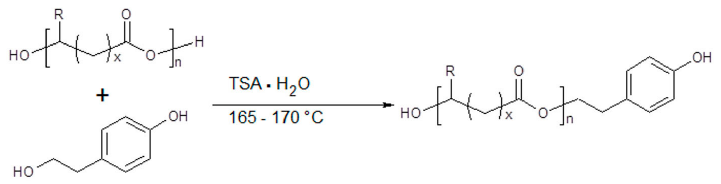
Table 1. Results of the transesterification reaction of P(3-HB- co -4HB) by tyrosol in the presence